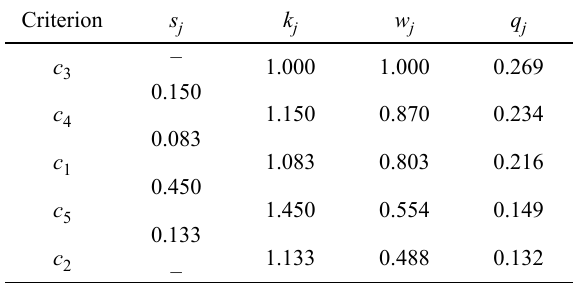
Table 4. Criteria parameters by SWARA method